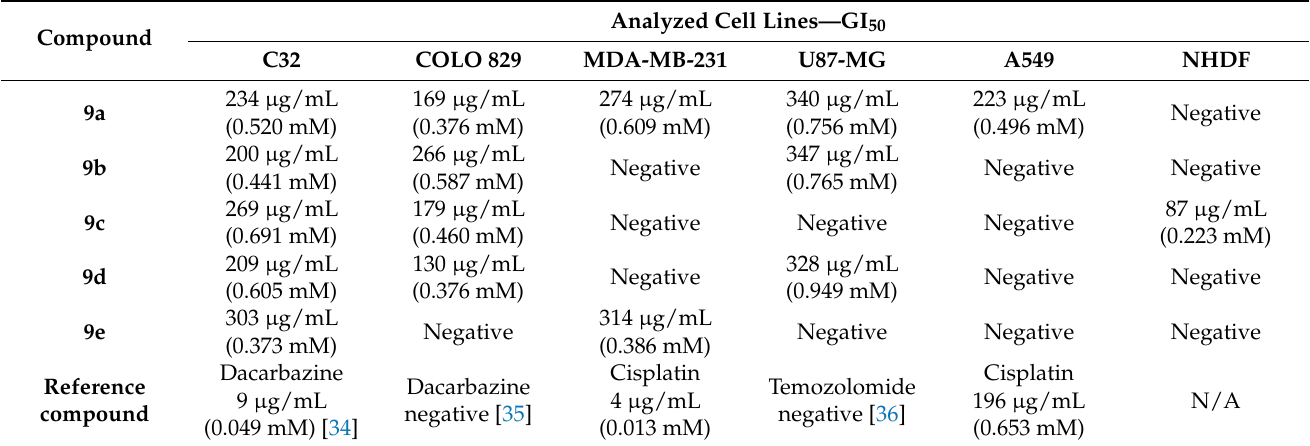
Table 2. The anticancer potential of synthesized compounds 9a–e expressed as GI50, i.e., the con- centration inhibiting cell growth by 50% as compared with control cells.